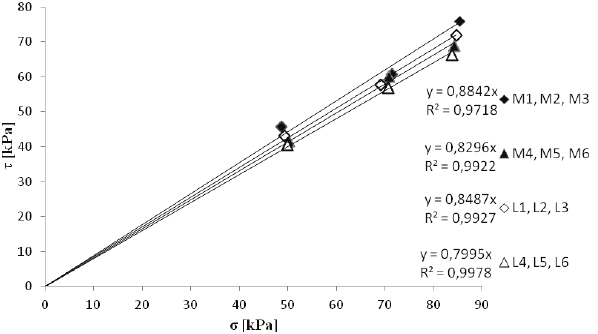
Fig. 5. Plot of shear stress to normal stress from direct shear tests for medium and large box